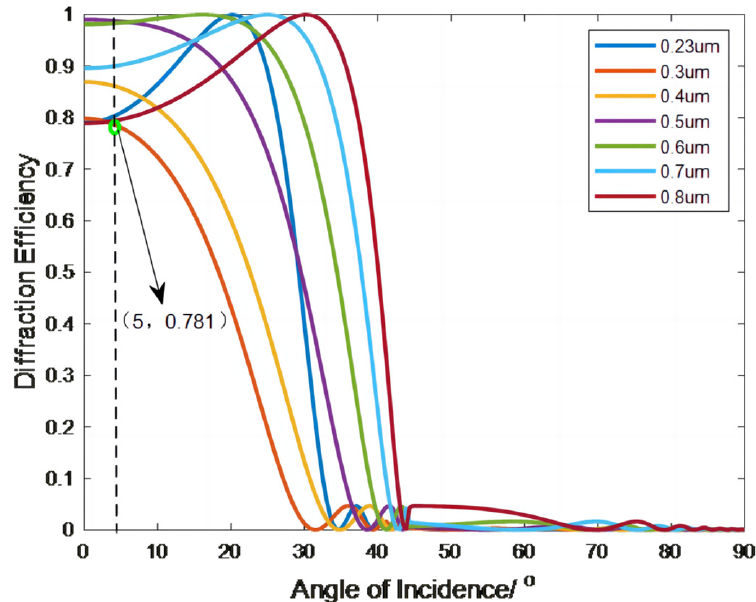
Figure 5. The diffraction efficiency curve of a double-layer DOEs substrate versus the angle of incidence.